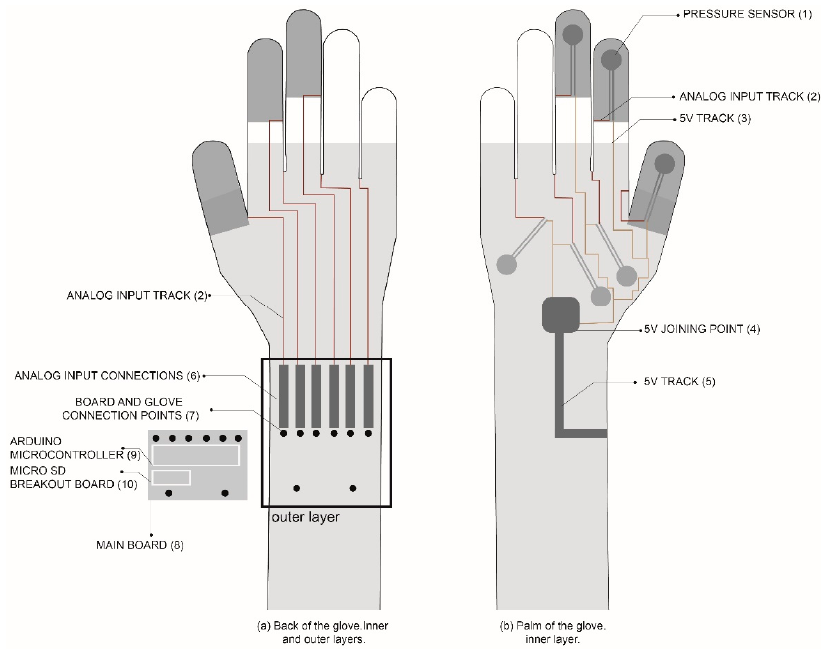
Figure 8. Final glove Figure 8 . Final glove arrangement.